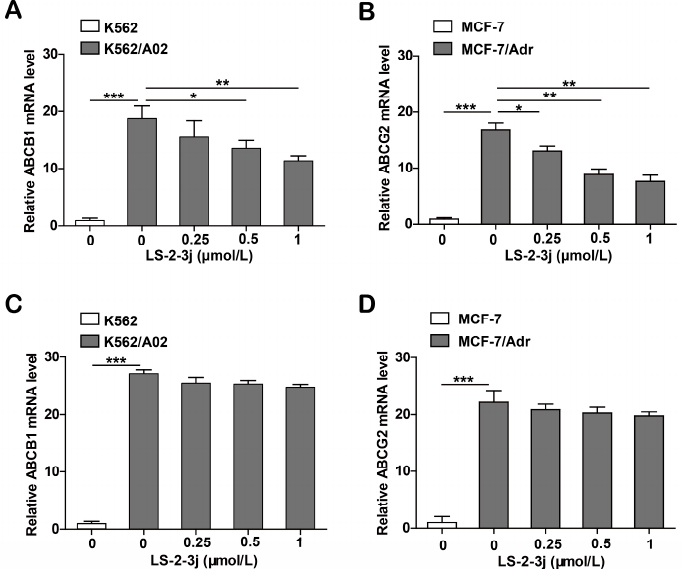
Figure 5. Analysis of LS-2-3j treatment on ABCB1 and ABCG2 mRNA levels in K562, K562/A02,